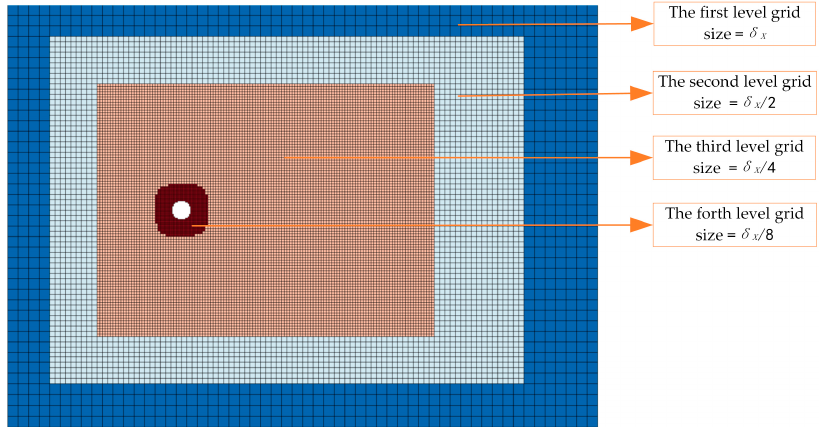
Algorithm 1. Initial grid generation algorithm.